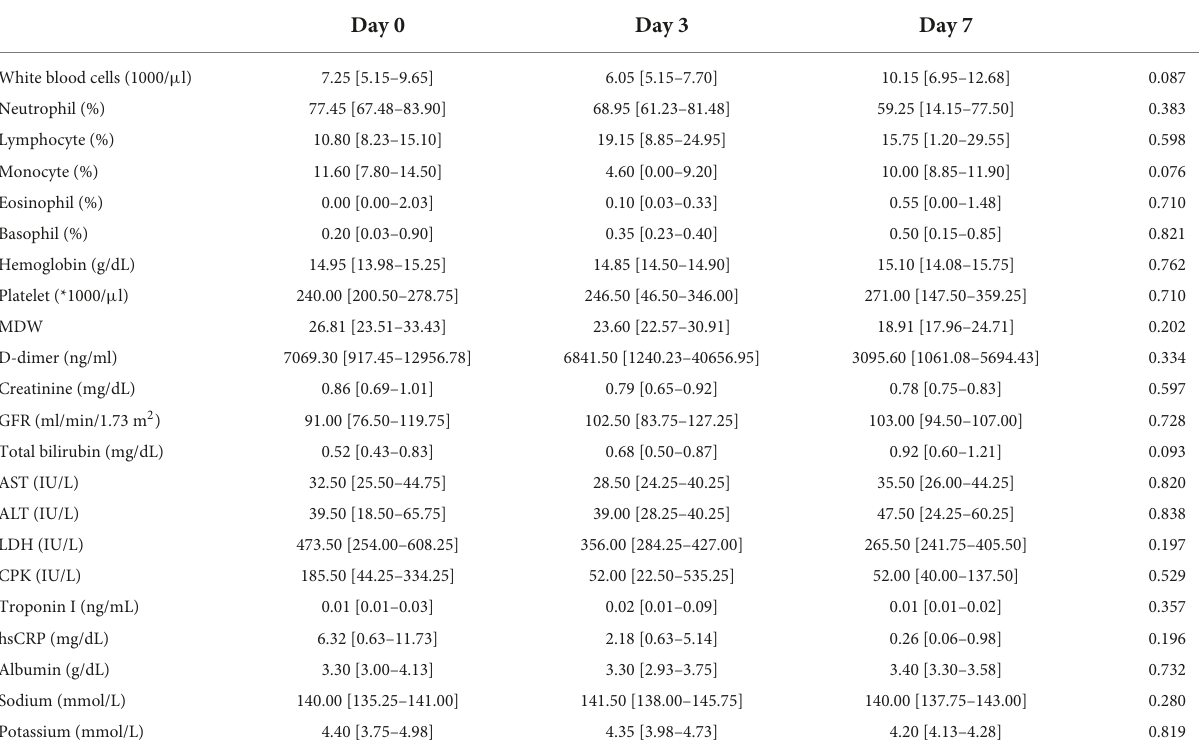
TABLE 3 Serial laboratory data of the non-human umbilical cord mesenchymal stem cell (non-hUC-MSC) group. Non-hUC-MSC group ( N =